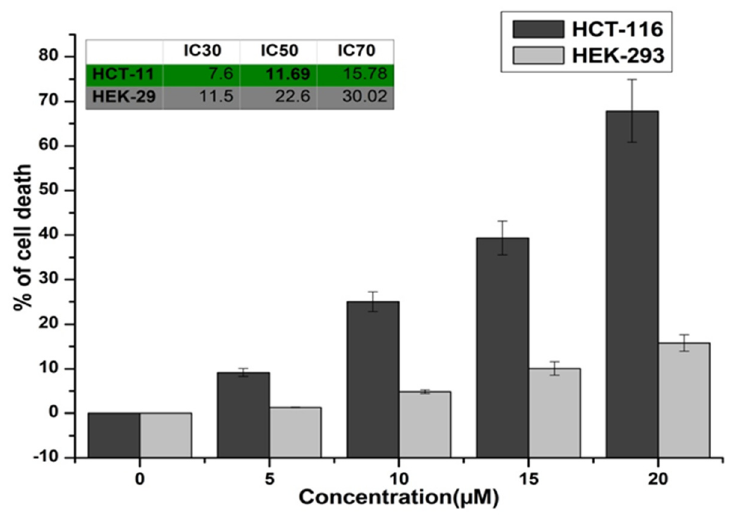
Figure 7. Rate of cell death of HCT 116 and HEK-293 cells treated with complex 1 (0–20 µ M) for 24 h.